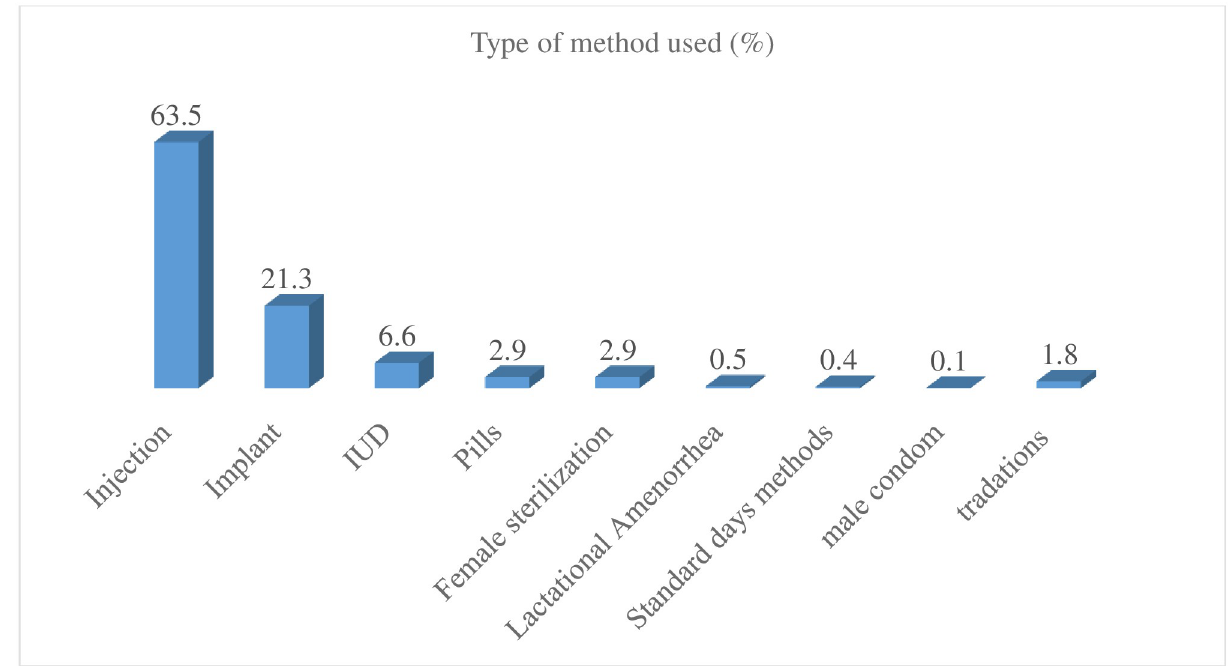
Fig 1. Contraceptive use by methods among fecund married women who want no more children in Ethiopia, 2016 EDHS.